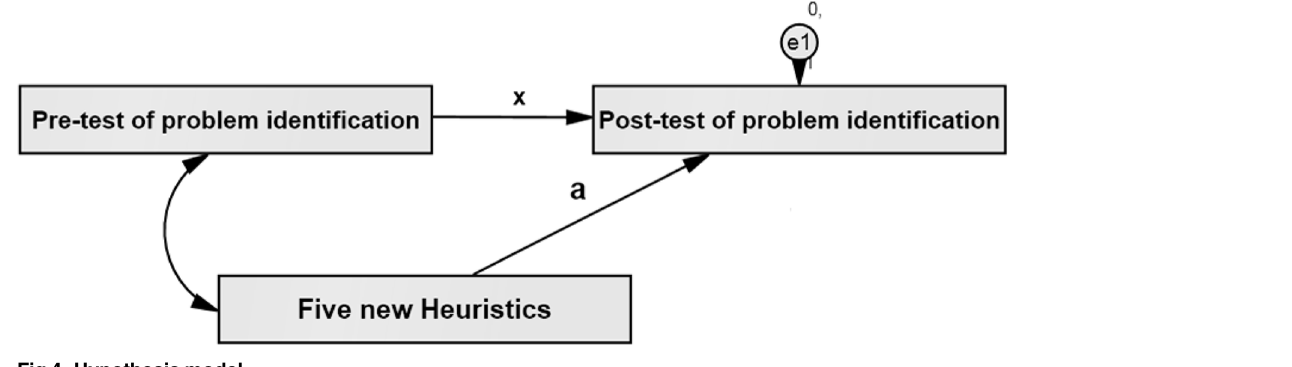
Fig 4. Hypothesis model.